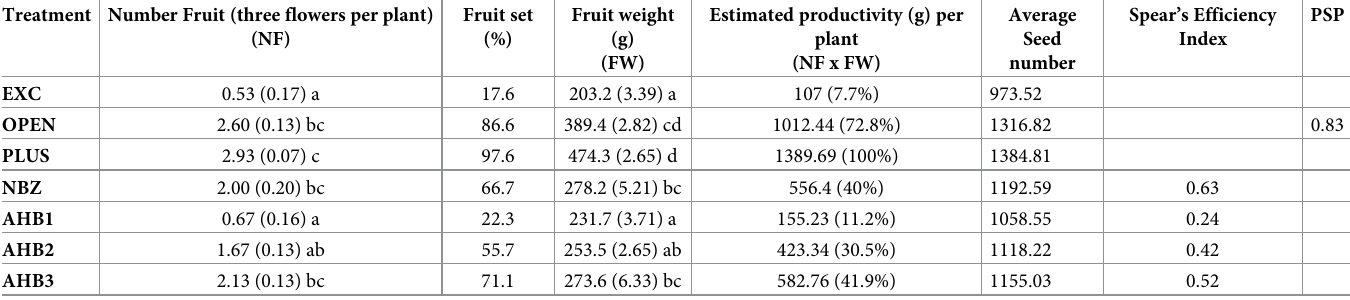
Table 2. Comparison of the average number of fruit and their weight obtained in seven treatments (see text for acronyms) applied to eggplant flowers. Estimations of Pollination Efficiency Index at single visits by NBZ and individual and multiple visits by AHB are also presented, together with estimation of overall Pollination Service Provision